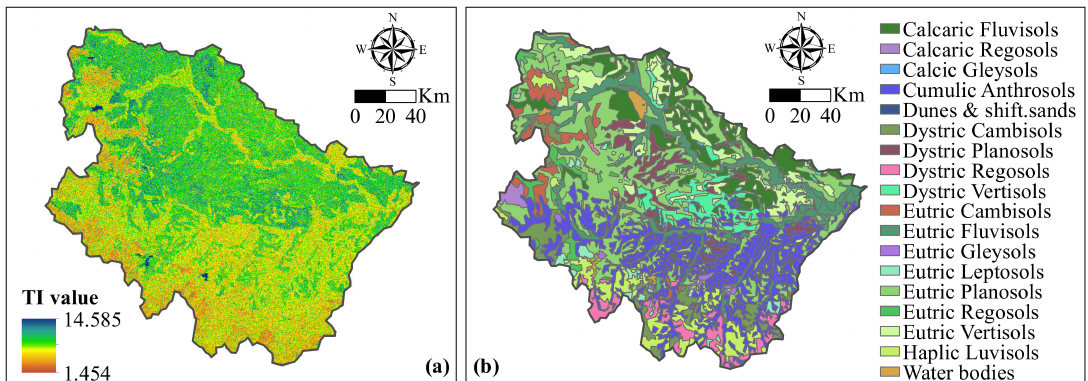
Figure 3. ( a ) The 1-km grid data of the topographic index (TI) of the WJB watershed; and ( b ) the applied soil type classification of the Harmonized World Soil Database (HWSD) used in the calculation of